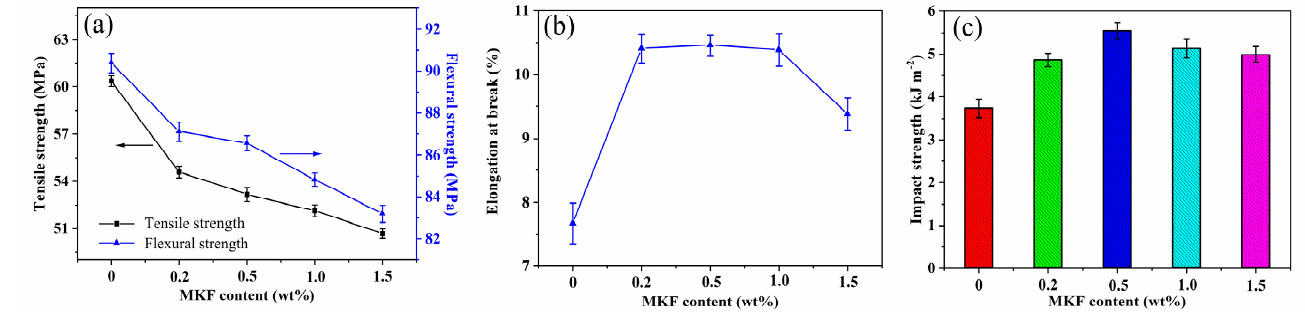
Figure 1. Mechanical properties of PLA/MKF biocomposites. ( a ) Tensile strength and flexural strength, ( b ) elongation at break, and ( c ) notched Izod impact strength.